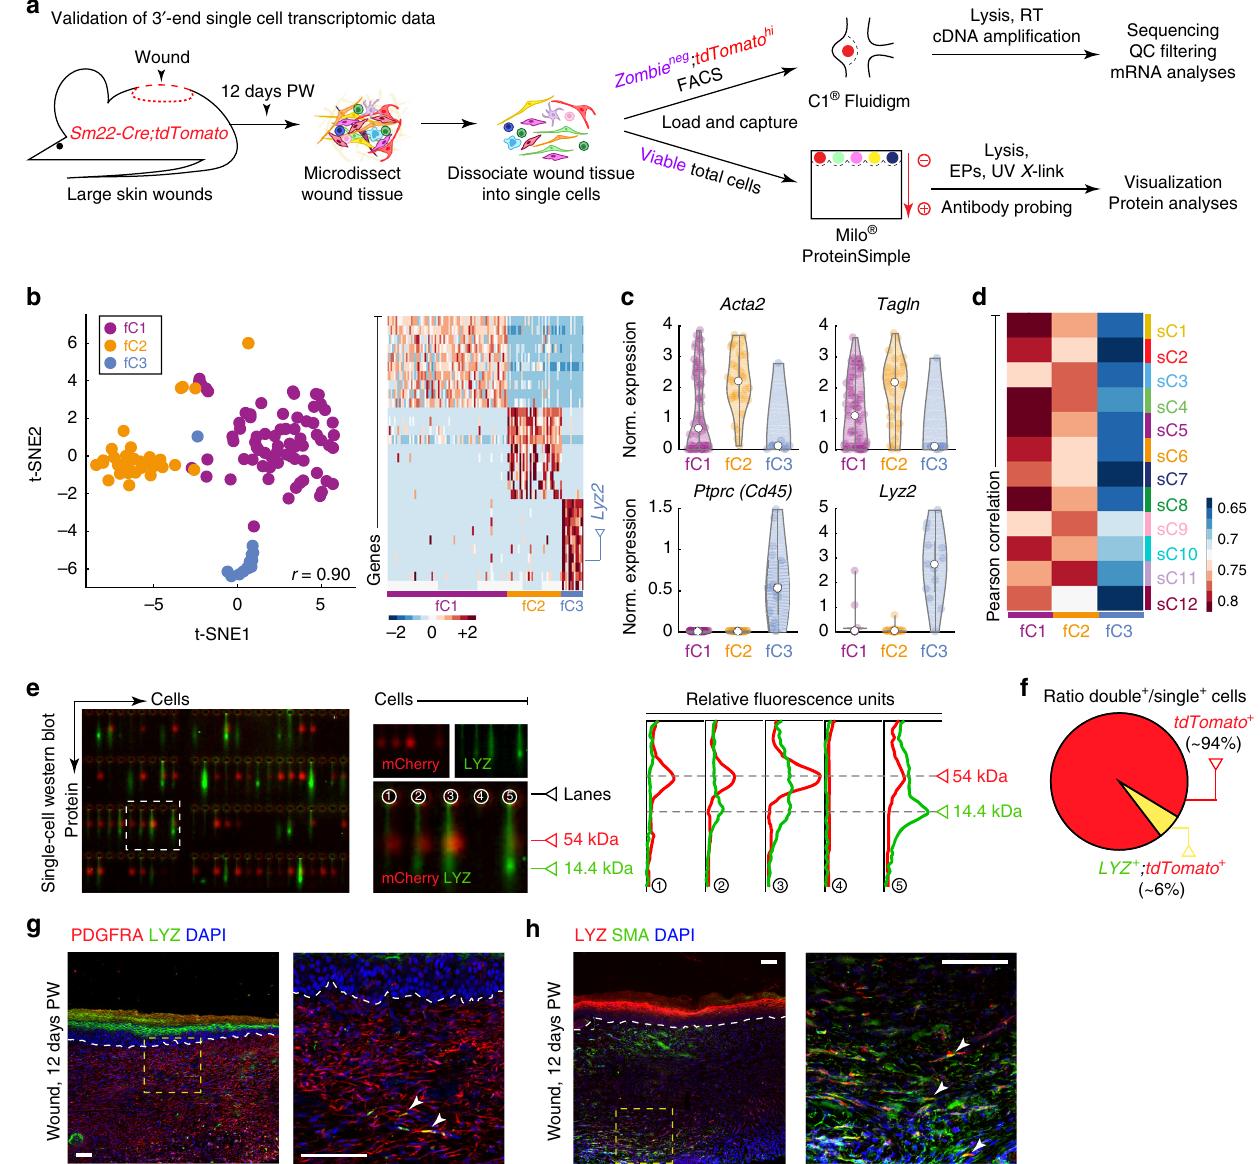
Fig. 5 Validation of myeloid-derived myo fi broblasts in day 12 wounds. a Schematic of cell isolation from day 12 wounds in Sm22-Cre;tdTomato mice, sorting for tdTomato + cells, capture by micro fl uidic device, sequencing and downstream analysis, and wound cell processing for single-cell western blot. b t-SNE plot revealed heterogeneity among tdTomato + wound cells. 116 sequenced cells were analyzed and three clusters were identi fi ed. Heatmap of top differentially expressed genes is shown on the right and Lyz2 is marked. c Violin plots of contractile markers Acta2 and Tagln , pan-hematopoietic marker Ptprc (aka Cd45 ) and myeloid marker Lyz2 . d Pearson correlation analysis between day 12 tdTomato + cell clusters and day 12 wound fi broblasts subclusters from Fig. 2a. e Single-cell western blot on unsorted cells from day 12 Sm22-Cre;tdTomato wounds revealed LYZ-expressing myo fi broblasts. Chips were co- stained for LYZ (green) and tdTomato (mCherry, red). Graph on the right shows LYZ + /tdTomato + double-positive cells in lanes #2, #3, and #5. Cell in lane #1 is single-positive for tdTomato and cell in lane #4 is double-negative. f Quanti fi cation shows that ~6% of tdTomato + wound cells co-express LYZ (77 out of 1293 cells). See also Supplementary Figure 14. g Co-staining of day 12 wounds for LYZ (green) and PDGFRA (red) identi fi ed occasional double- positive fi broblasts. h Co-staining of day 12 wounds for LYZ (red) and SMA (green) identi fi ed occasional double-positive myo fi broblasts. Immunostaining images shown on g and h are representative of the marker staining patterns observed in three or more independently stained samples. PW: post-wounding, FACS: fl uorescence-activated cell sorting, RT: reverse transcription, EP: electrophoresis, QC: quality control. Size bars: g , h — 100 µ mesenchymal structures in the digit tip regenerate from several types of fate-restricted progenitors and no multipotent progeni- tors or lineage reprogramming events are observed 48,49 . In con- trast, large skin wounds demonstrate broadened lineage plasticity.